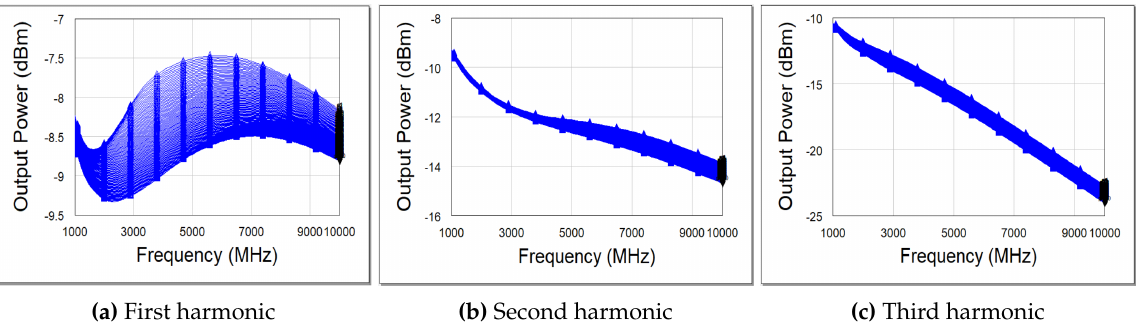
Figure 3. Received powers at first three harmonics of the cascaded amplifier circuits.